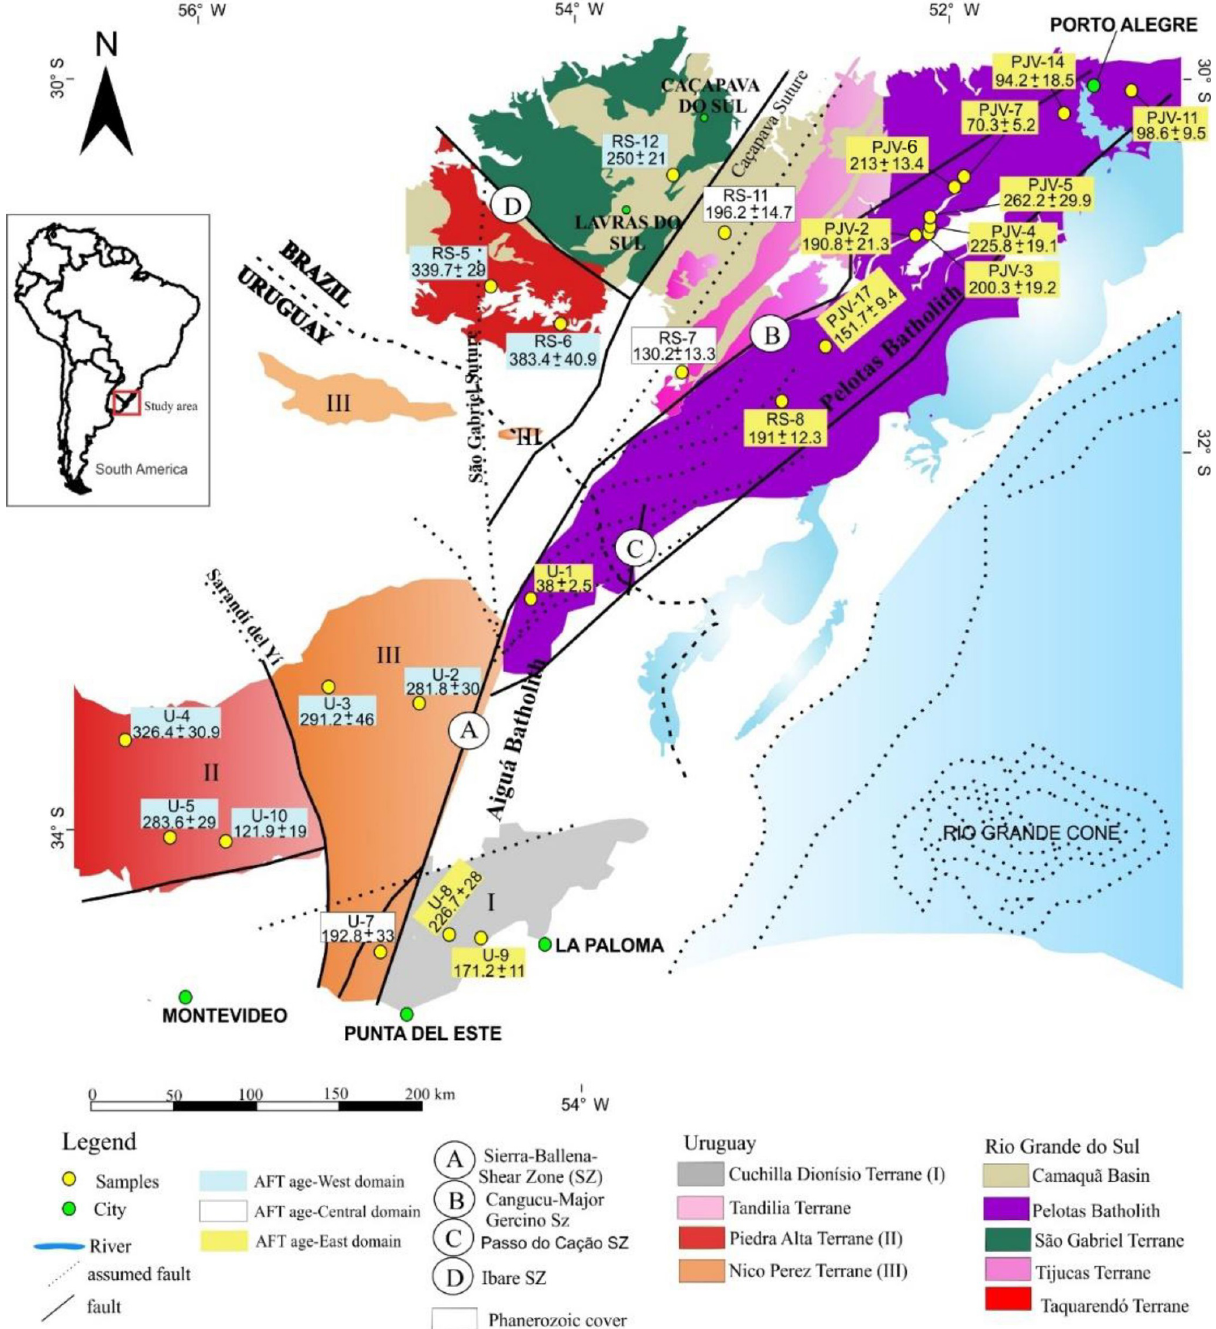
Figure 1. Simplified geological map of the Dom Feliciasno Belt in Uruguay and Rio Grande do Sul State, Brazil, and shear zones showing samples locations. Regional distribution of AFT ages ( ± 1 σ ) of the working area. In the blue boxes, AFT ages of West Domain of Dom Feliciano Belt; in the white boxes, AFT ages of Central Domain; and in the yellow boxes, AFT ages of East Domain (adapted after Castillo Lopes, 2009; Chemale Jr. et al., 2012; de Oliveira et al., 2016; and Gruber et al.,